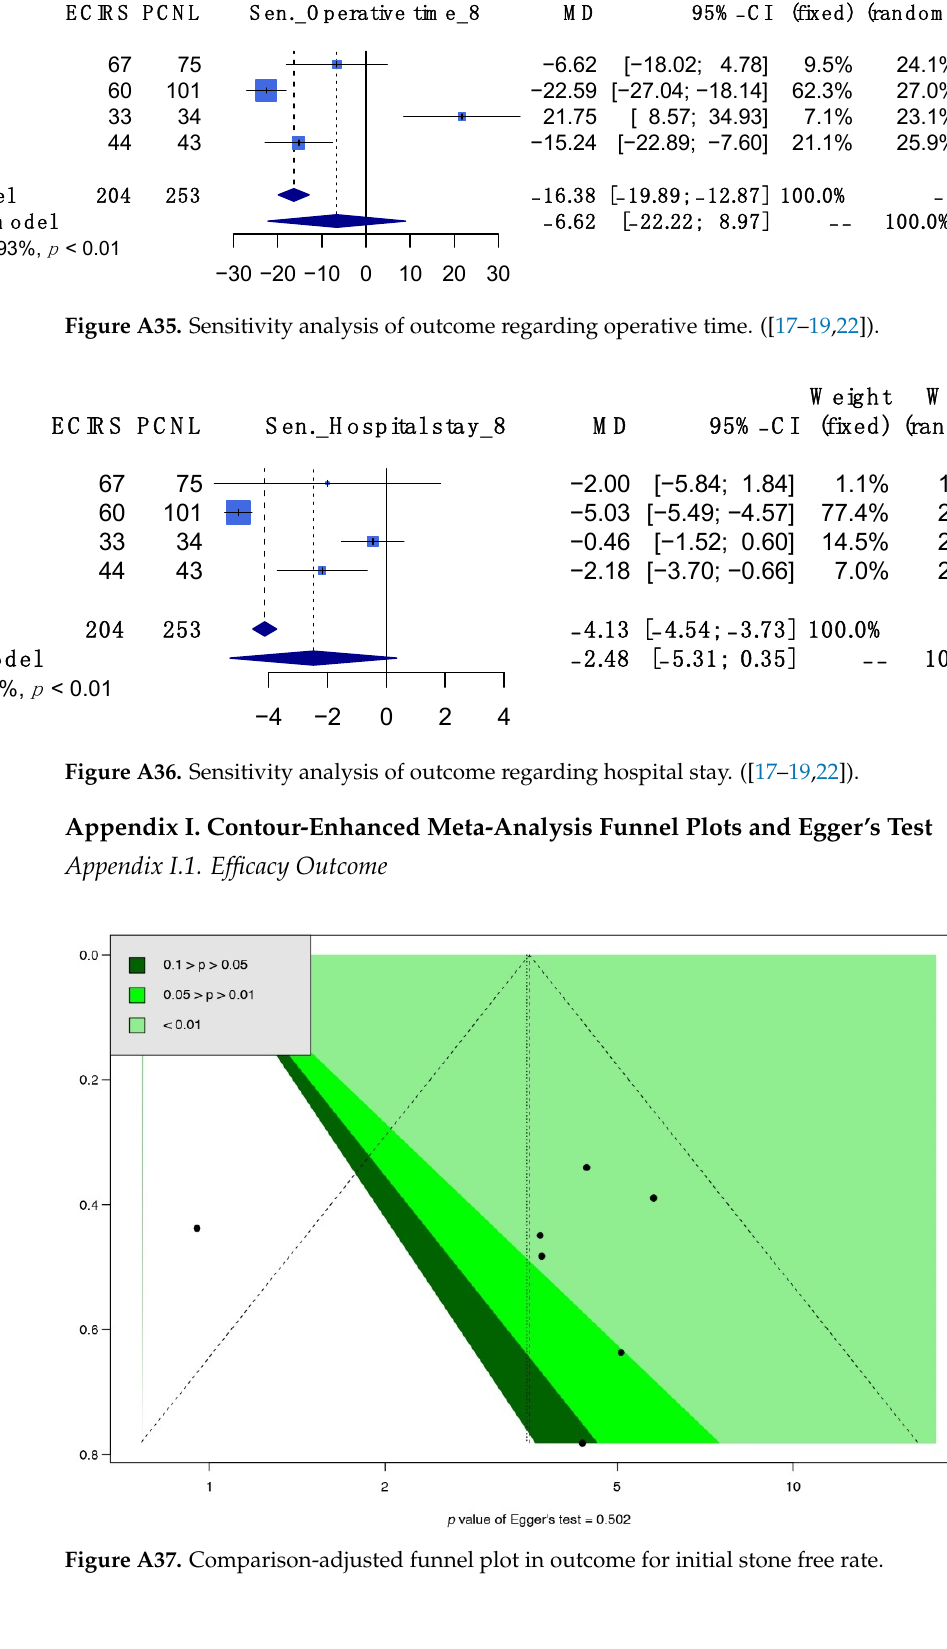
Figure A38. Comparison-adjusted funnel plot in outcome for final stone free rate. Appendix I.2. Safety Outcome